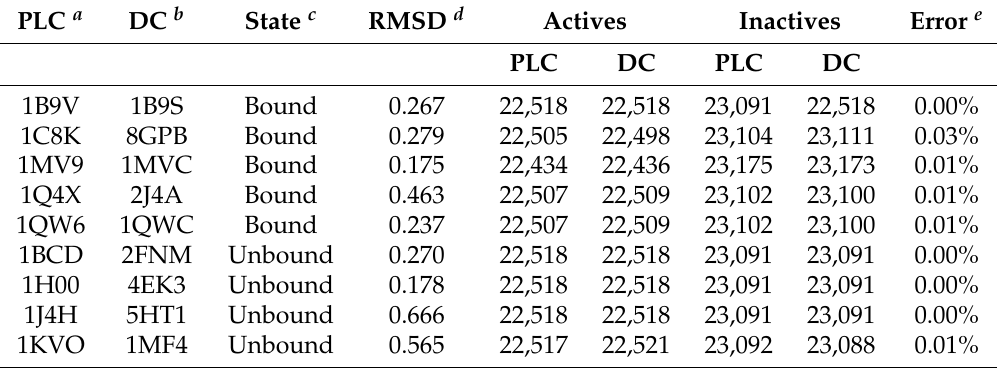
Table 8. Comparison on performance of SSnet on different conformations of a